Question: Based on the figure, does the quantity rise or fall?
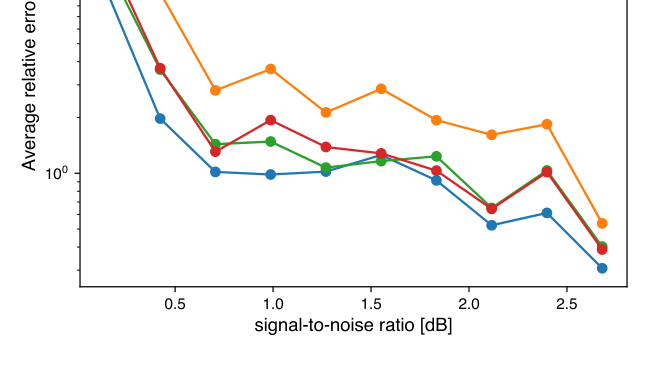
Answer: increasing